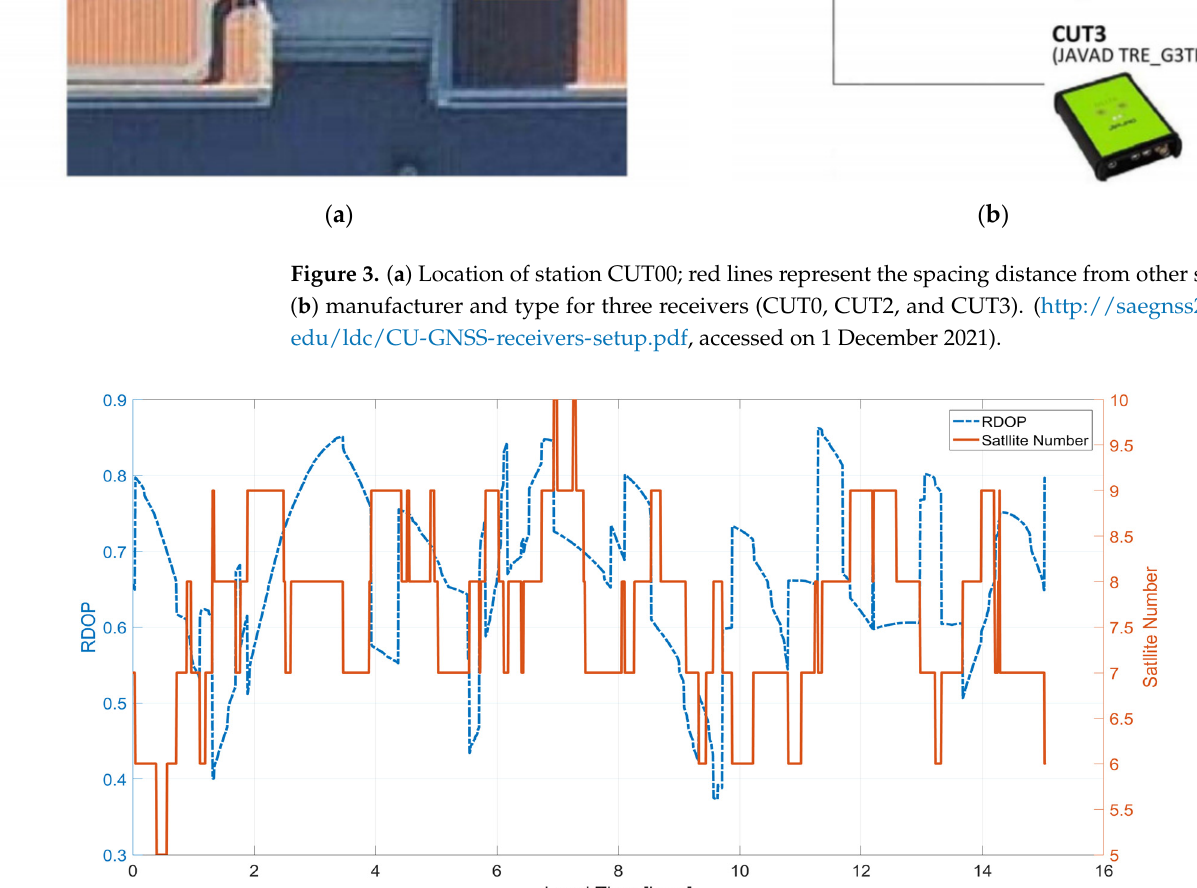
Figure 4. RODP and available satellites of station CUT00.